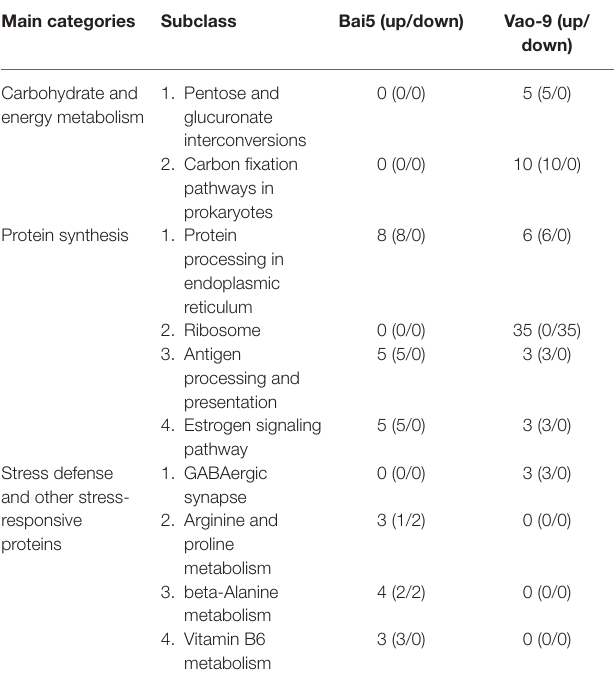
TABLE 3 | The numbers of DEPs from main functional categories in Bai5 and